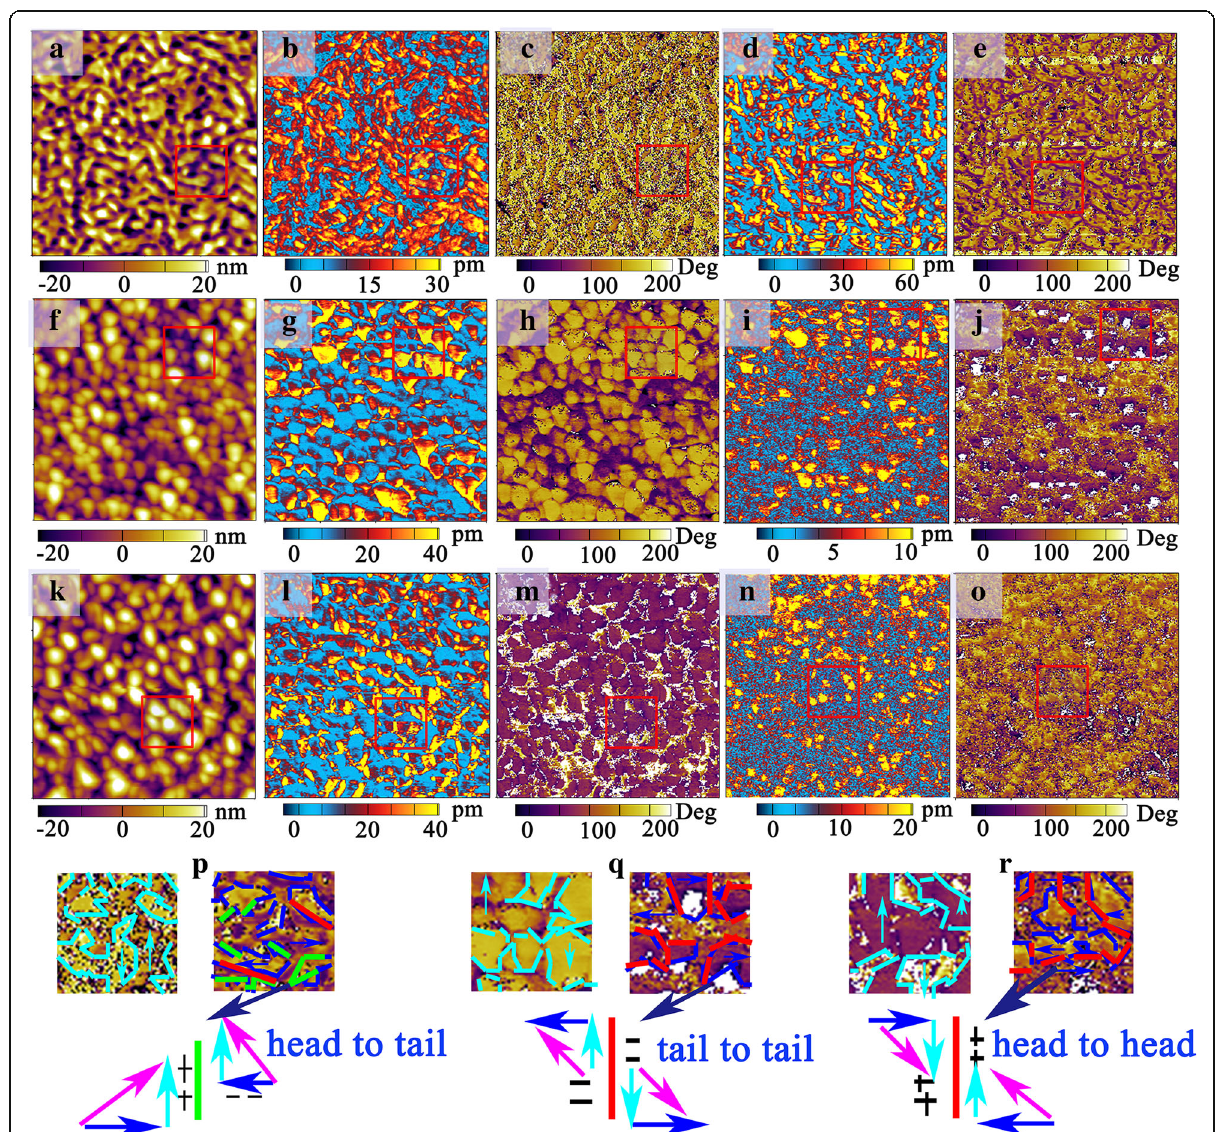
Fig. 7. AFM surface topography, OP PFM amplitude images, OP PFM phase images, IP PFM amplitude images, IP PFM phase images, and zoomed-in PFM images of a specific region in the red solid square: a – e, p for BNTM-1, f – j, q for BNTM-2, k – o , r for BNTM-3, respectively, and the scanning area is 2 × 2 μ m